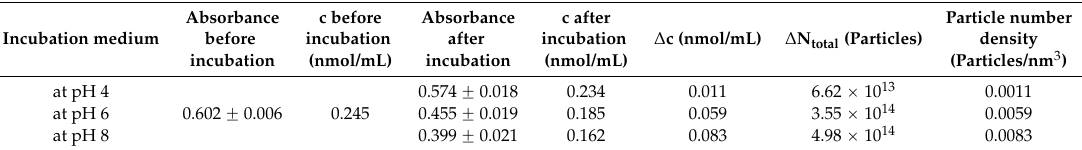
Table 5. Particle number densities of AuNPs within PMETAC brushes obtained by UV/Vis of composites incubated at different